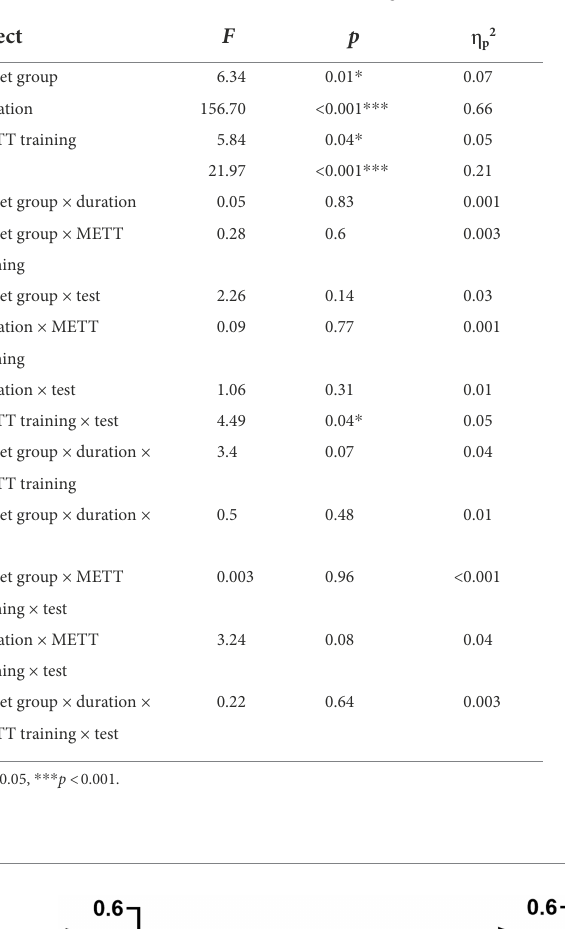
TABLE 1 The results of mixed model ANOVA in Study 1A.